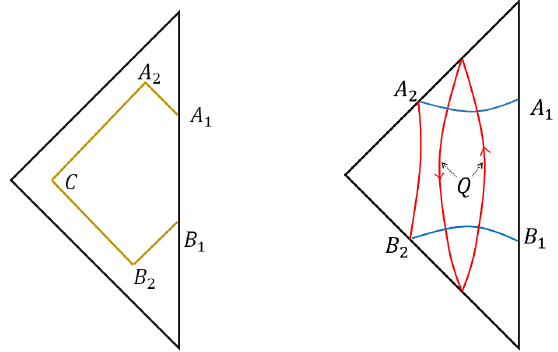
Figure 4 . Left: for a timelike interval in a Poincaré patch of AdS 3 spacetime, we can always use four null geodesics to connect its endpoints. Such piecewise null geodesics has infinitely many different choices but they all have zero area. Right: the CWES contains a connected branch A 1 A 2 B 2 B 1 and a closed timelike branch Q